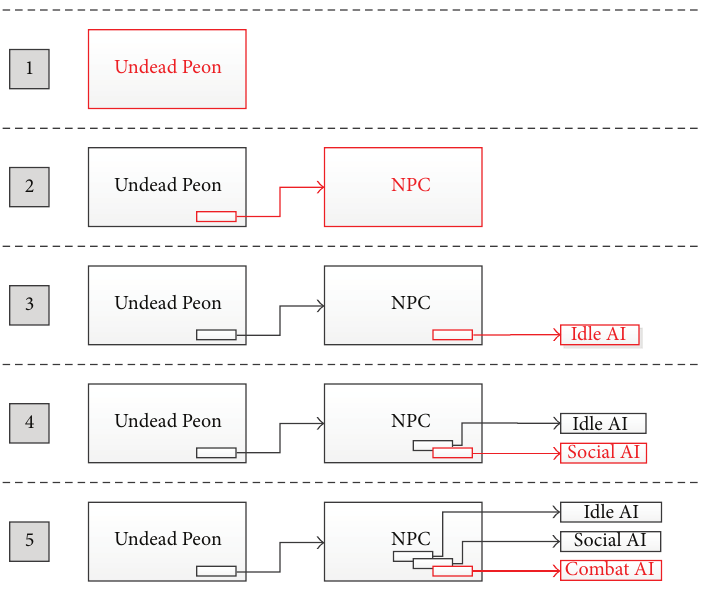
Figure 9: Registering multiple controllers with a conceptual object. Depending on its state, the Undead Peon is controlled by one of the three AI